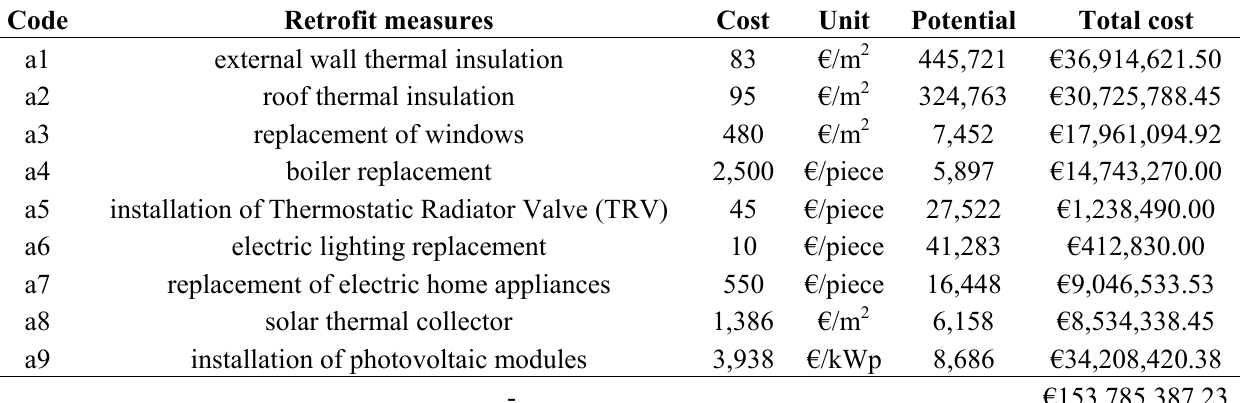
Table 2. List of the energy retrofit measures that were considered in the case study and the relative costs and real potentials